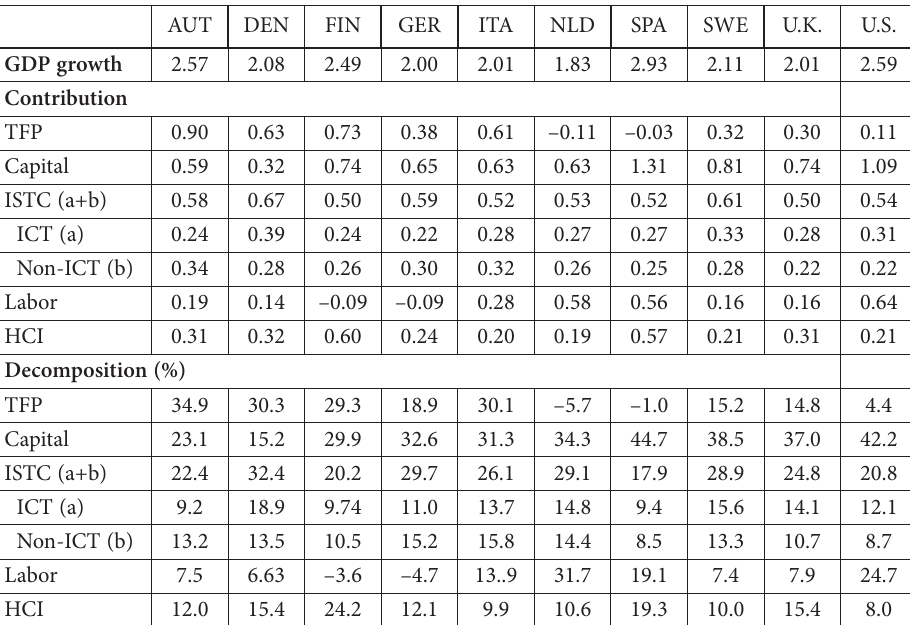
Table 5. Jorgenson’s method. GDP Growth Decomposition, 1980–2010 AUT DEN